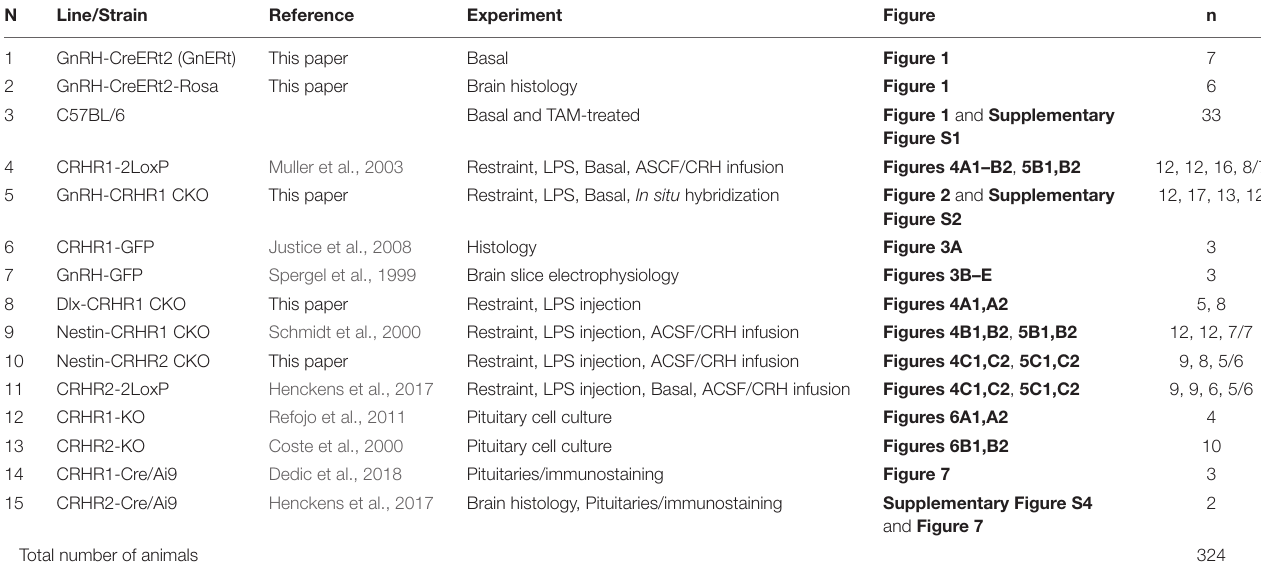
TABLE 1 | List of transgenic mouse